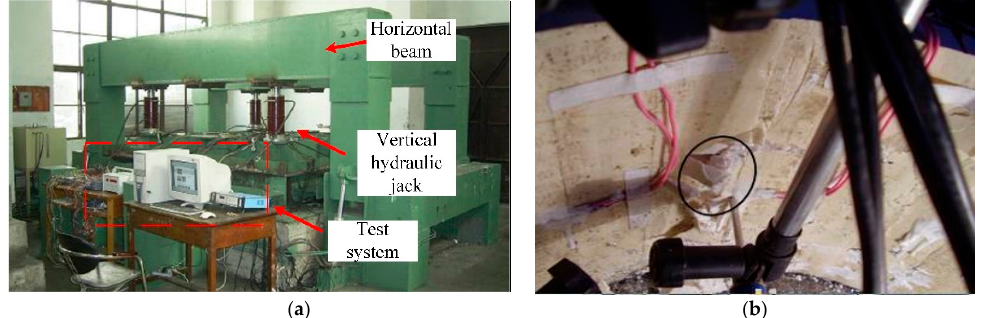
Figure 8. Entire life cycle loading and destructive model test for the secondary lining. ( a ) Test equipment diagram; ( b ) Failure diagram of lining structure. Table 3. The evaluation criteria for the stress characteristics of the structure in the evaluation model.